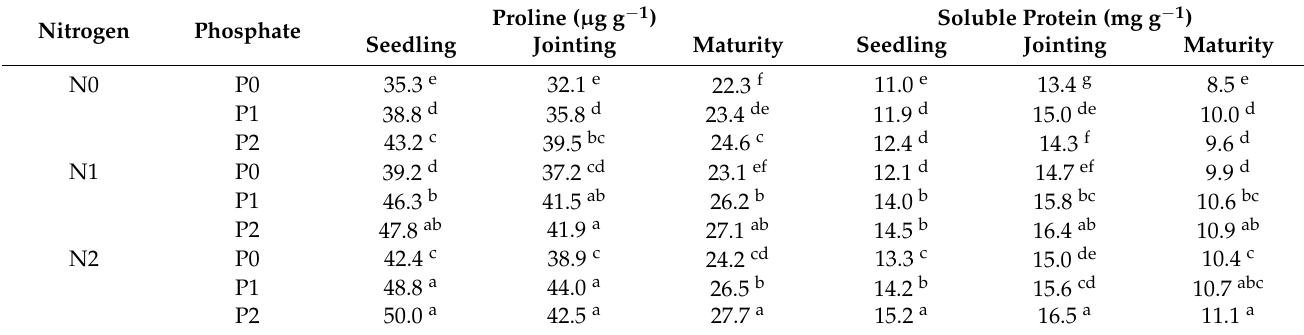
Table 5. Effects of nitrogen and phosphorus on proline and soluble protein content of sorghum plants grown in saline soils at the three growing stages of seedling, jointing, and maturity.